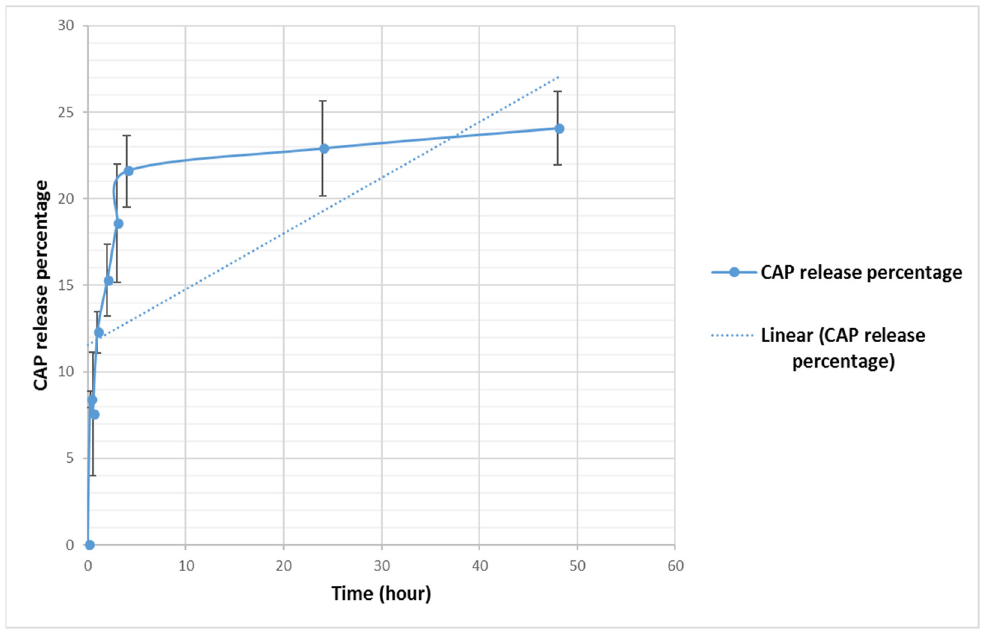
Figure 4. In vitro release of CAP from CAP-loaded nanoliposomes, monitored over 48 h at 37 °C. All values represent the average ± SD of three independent experiments.